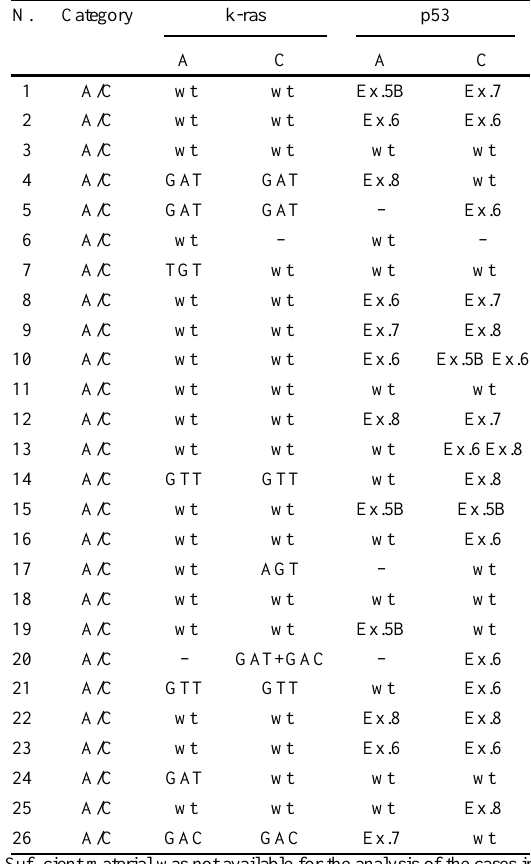
Analysis of k-ras and p53 mutations for 26 human colorectal ade- nomas containing early cancer (A/C). Adenomatous (A) and carci- nomatous (C) components were analysed separately